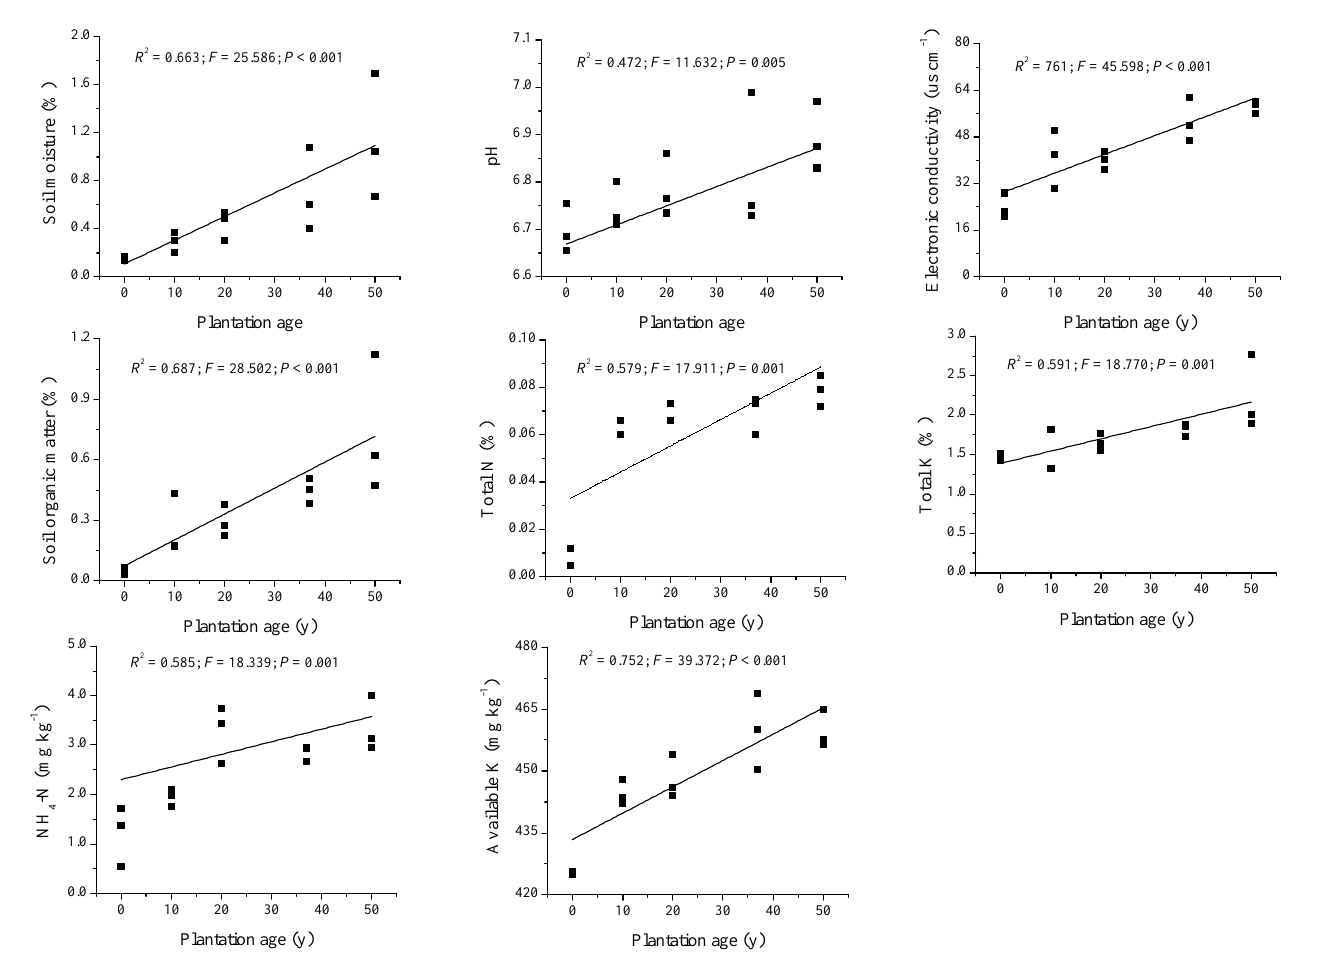
and phosphorite dissolution were 2.65% and 0.11%, respectively, and linearly increased with the plantation age ( p < 0.05, Figure 3).